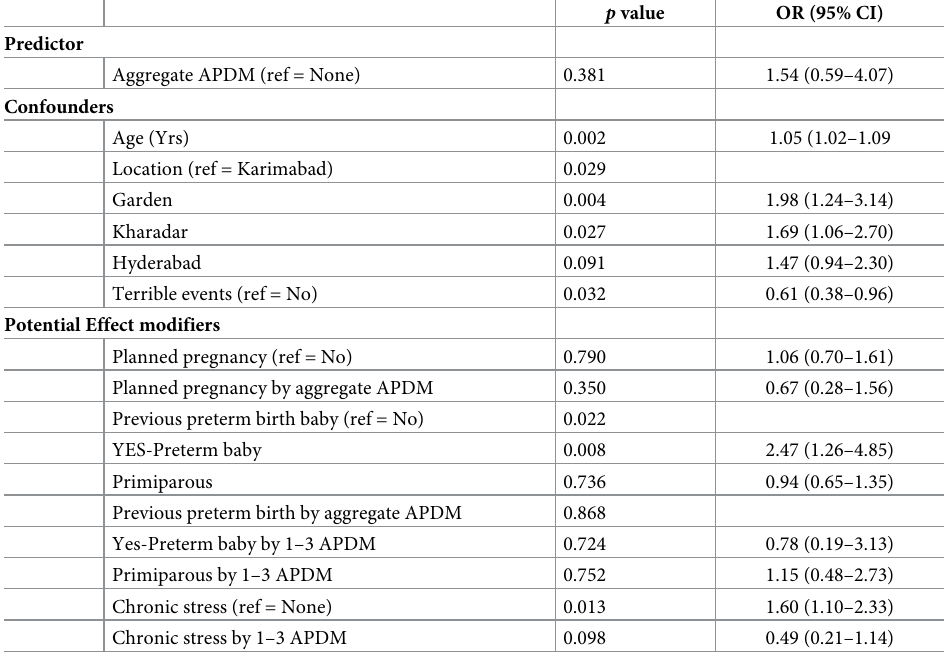
Table 4. Model for preterm birth given aggregate antenatal psychosocial distress